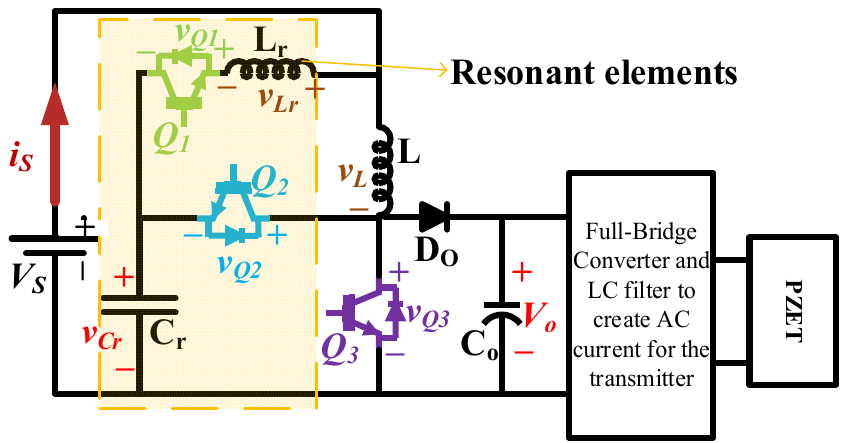
Figure 2. The proposed DC-DC power converter topology with highlighted resonant elements.